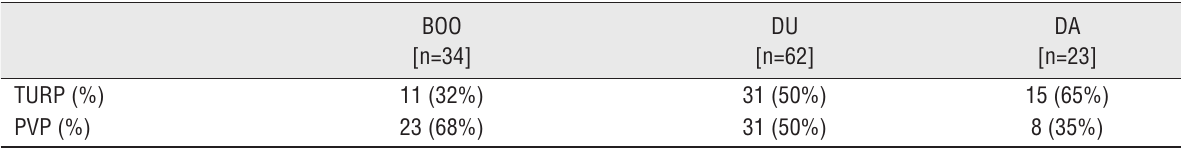
Table 1 - Type of BPO surgery performed in each